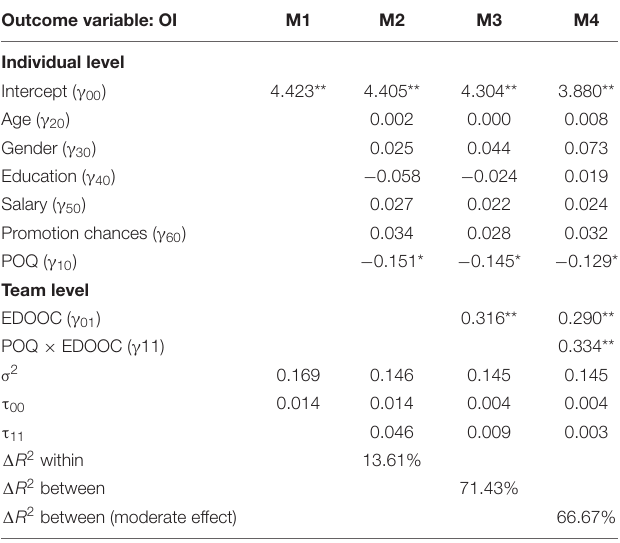
TABLE 3 | Results for multi-level path analysis.